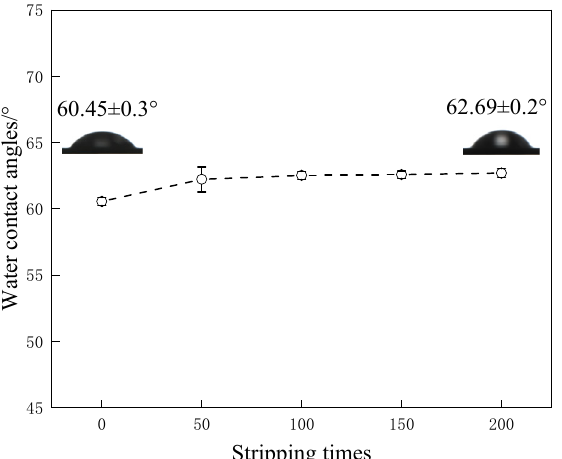
Figure 4. ( a ) Image of carbon steel and PDA-Ni coating, and ( b ) SEM-, ( c ) EDS-, and ( d ) EDS-layered image for PDA coating.